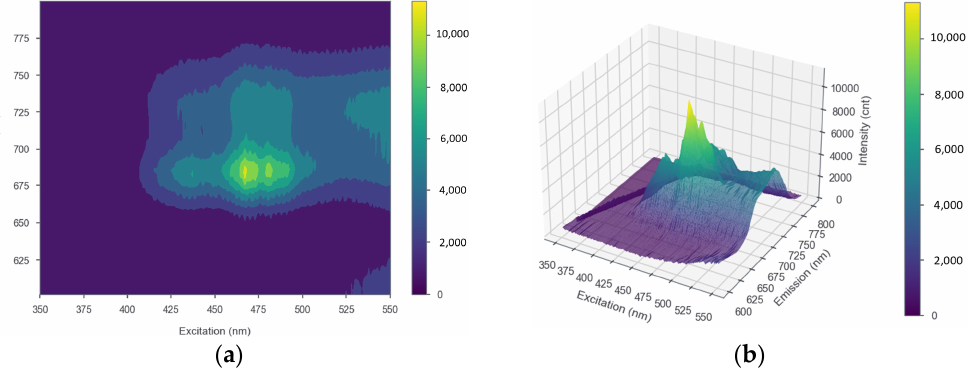
Figure 4. ( a ) 2D and ( b ) 3D EMEX matrices of strawberry leaves as a result of measurements using a spectrofluorometer. The x, y, and z axes show excitation, emission, and intensity, respectively.